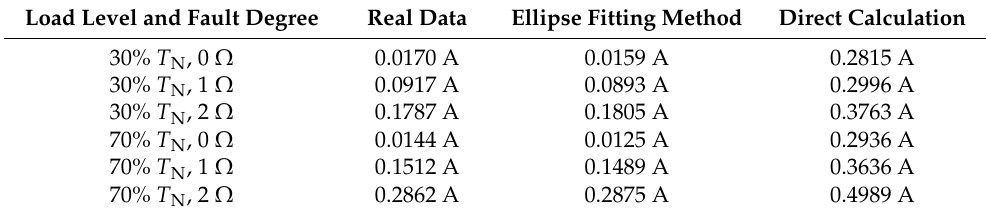
Table 1. Comparison of different methods for calculating negative sequence current.